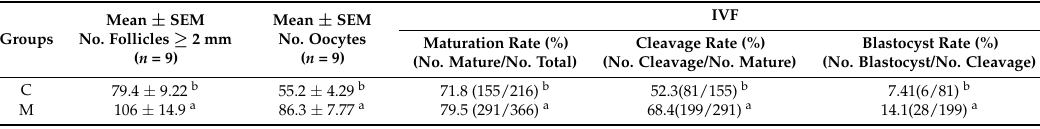
Table 1. Effect of melatonin on lamb superovulation.